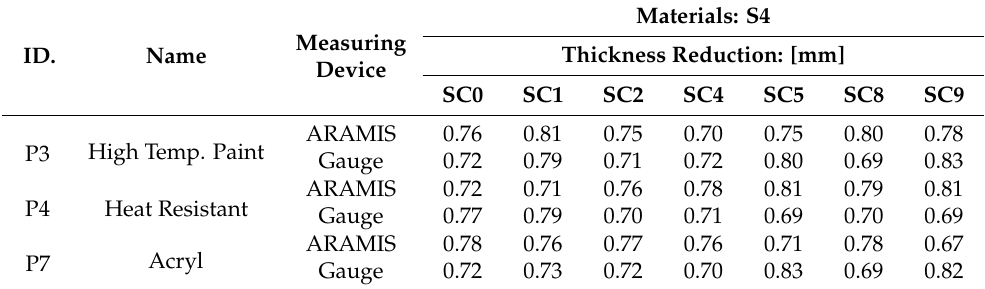
Table 12. Comparison of ARAMIS and thickness measurement